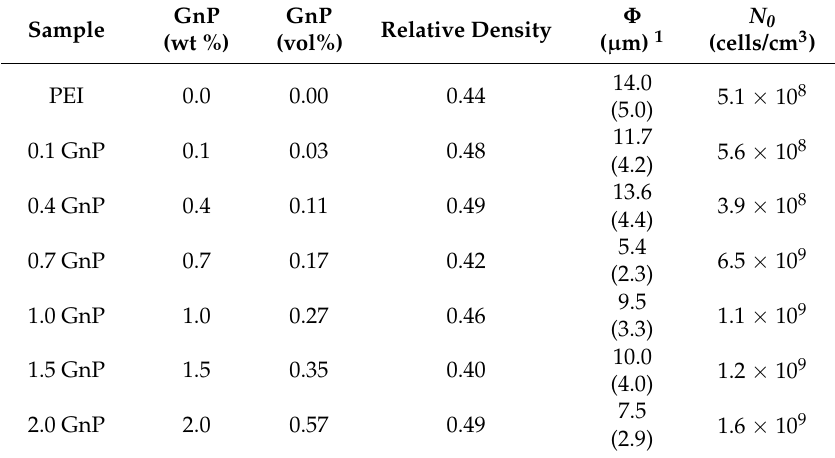
Table 1. Composition, relative densities, and cellular structure characteristics of PEI and PEI-GnP nanocomposite